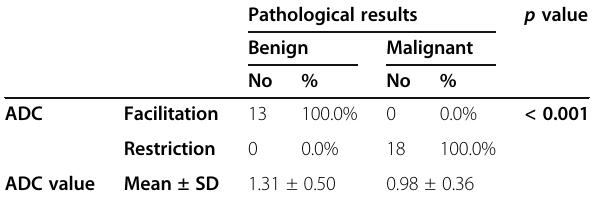
Table 3 Comparison between pathological results as regards MRI findings: ADC and ADC